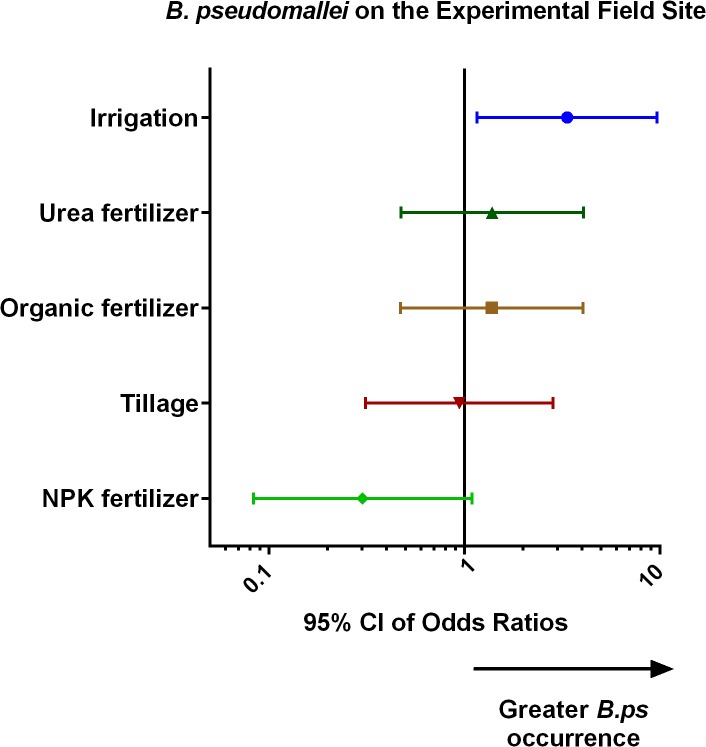
Results of the analysis on the occurrence of B. pseudomallei on the experimental field site.The odds ratio refers to the ratio of the odds of B. pseudomallei occurring in soil samples taken a year or more into the experiment from the treatment quadrants to the odds of B. pseudomallei occurring in soil samples from the control quadrants.